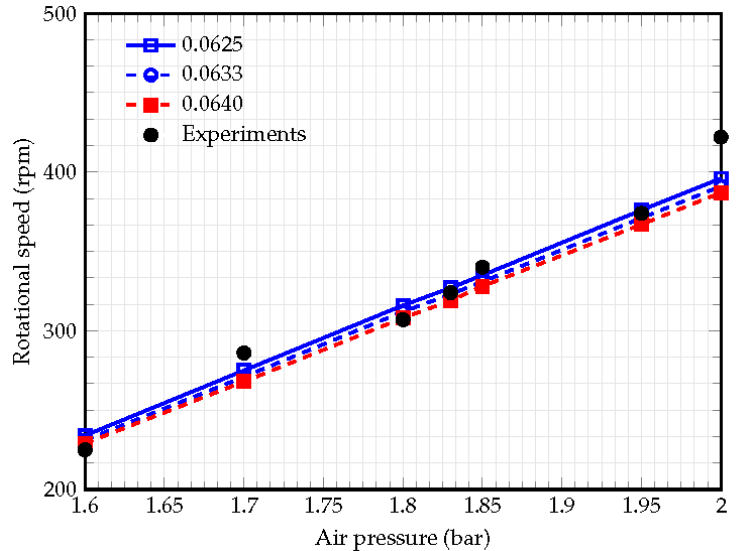
Figure 11. Comparison of experimental and simulated rotational speed vs. inlet air pressure with f overall of 0.0625, 0.0633, and 0.0640